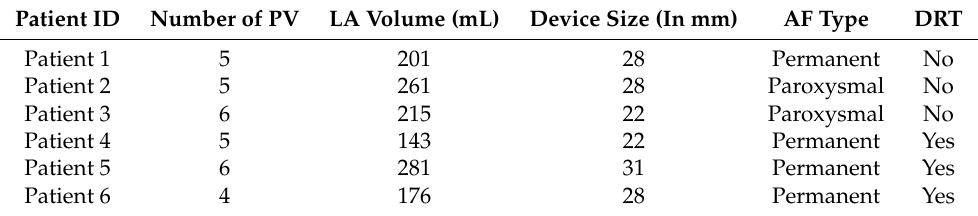
Table 2. Left atrial (LA) and clinical characteristics of the studied cases. PV: pulmonary veins; AF: atrial fibrillation; DRT: device-related